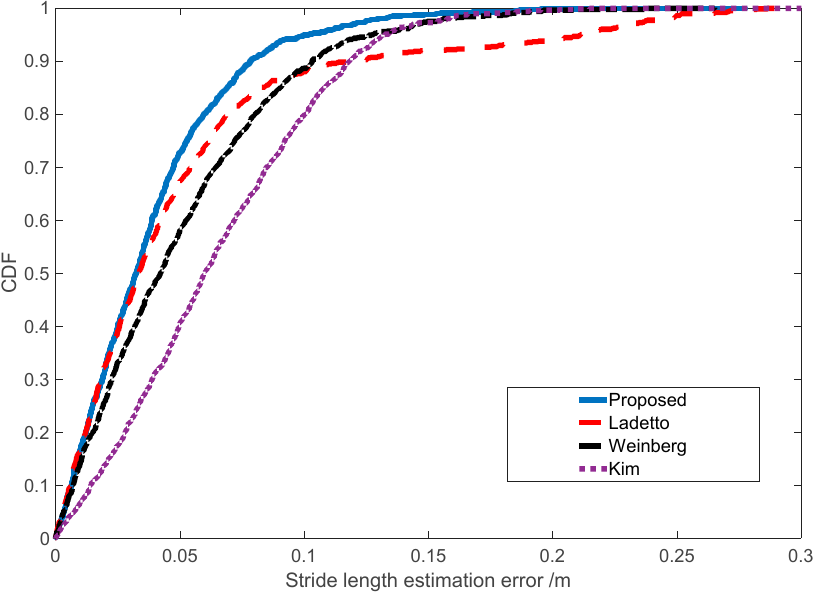
Figure 11. The estimation error of proposed model and other methods.